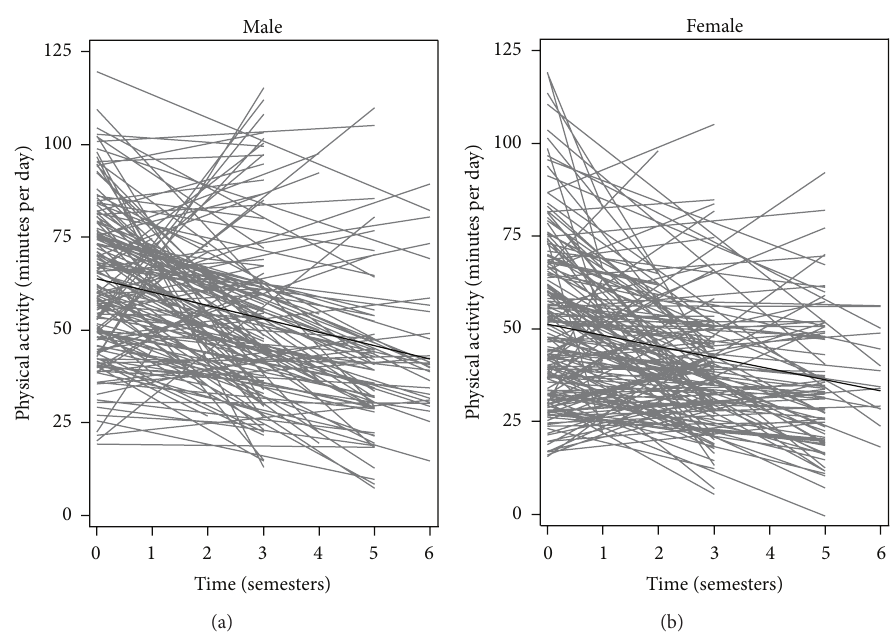
Figure 1: Physical activity trajectories of students from April 2008 to December 2011, by gender. Linear regressions of physical activity (minutes per day) across semesters for each student with baseline and at least 1 valid follow-up measurement, by gender, are shown in gray. Linear growth curves showing averaged baseline physical activity and averaged rate of change in physical activity among all students, by gender, are shown in